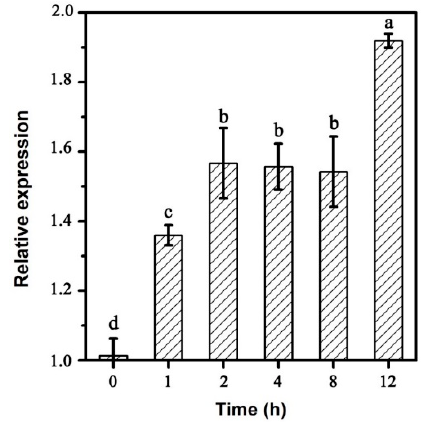
Figure 3. Relative normalized expression of degradation gene (opdB) in degradation process. All values are means ± standard deviation of triplicate measurements. Mean values with the same letter (a, b, c and d) are not significantly different among reaction time (0 to 12 h) by LSD at the 5% level.